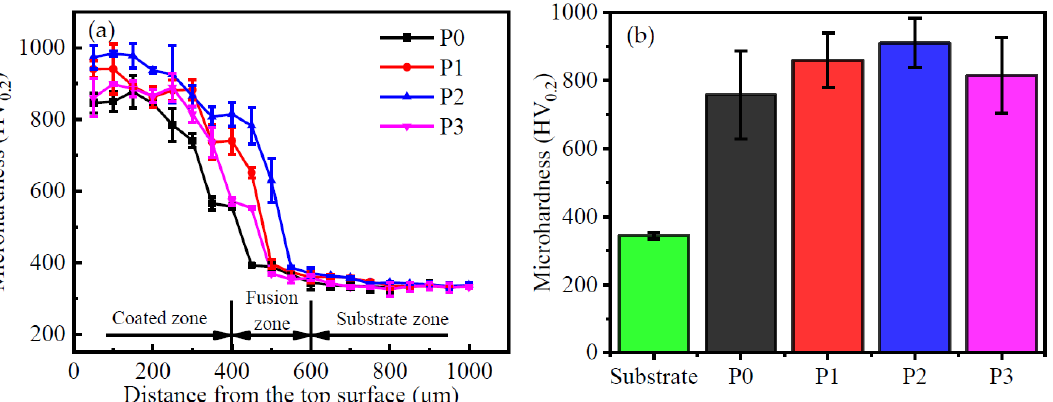
Figure 10. ( a ) Micro-hardness distribution curves of coatings fabricated with different ultrasonic vibration power along the depth direction, ( b ) The average micro-hardness values of the coated zones.